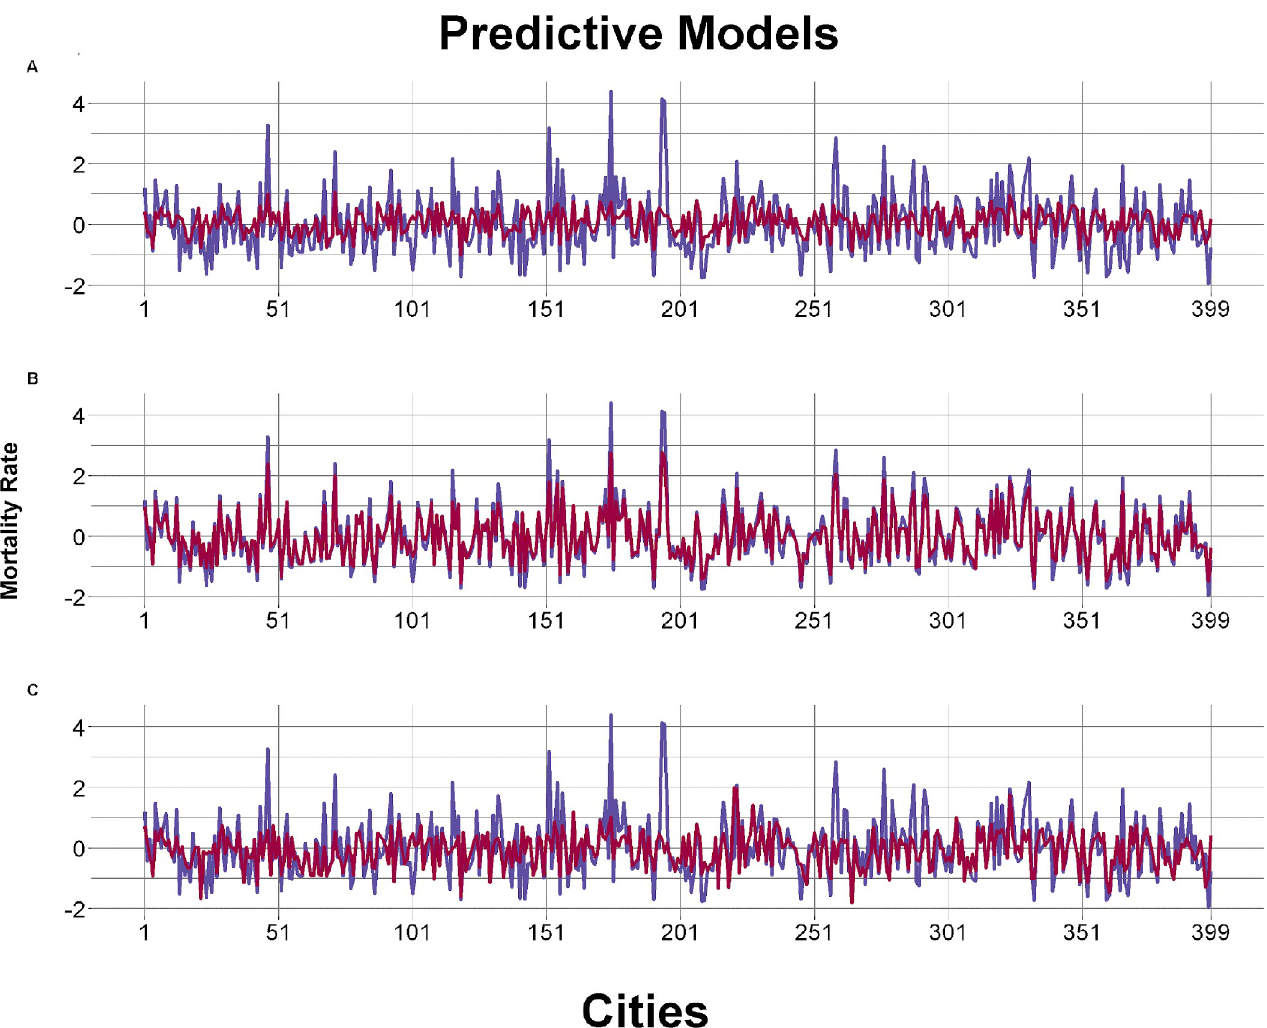
Fig 3. Calibration graphs of the tested predictive models (adjustments using RMSE). A- Example of underfitting calibration model with the worst adjustment (K-Nearest Neighbors); B- Example of overfitting calibration model (Random Forest); C: Example of best fit model (Support Vector Machine). Blue represents the observed mortality rate and red represents the predicted